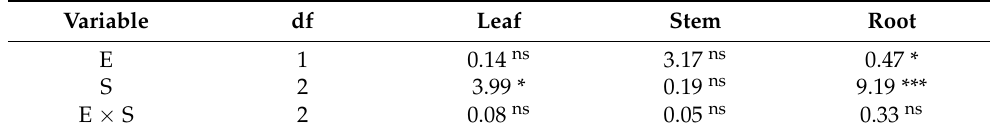
Table 5. Two-way ANOVA for the effects of endophyte (E) and CdCl 2 stress(S) on subcellular distribution of Cd in leaves, stems, and roots of Hordeum brevisublatum